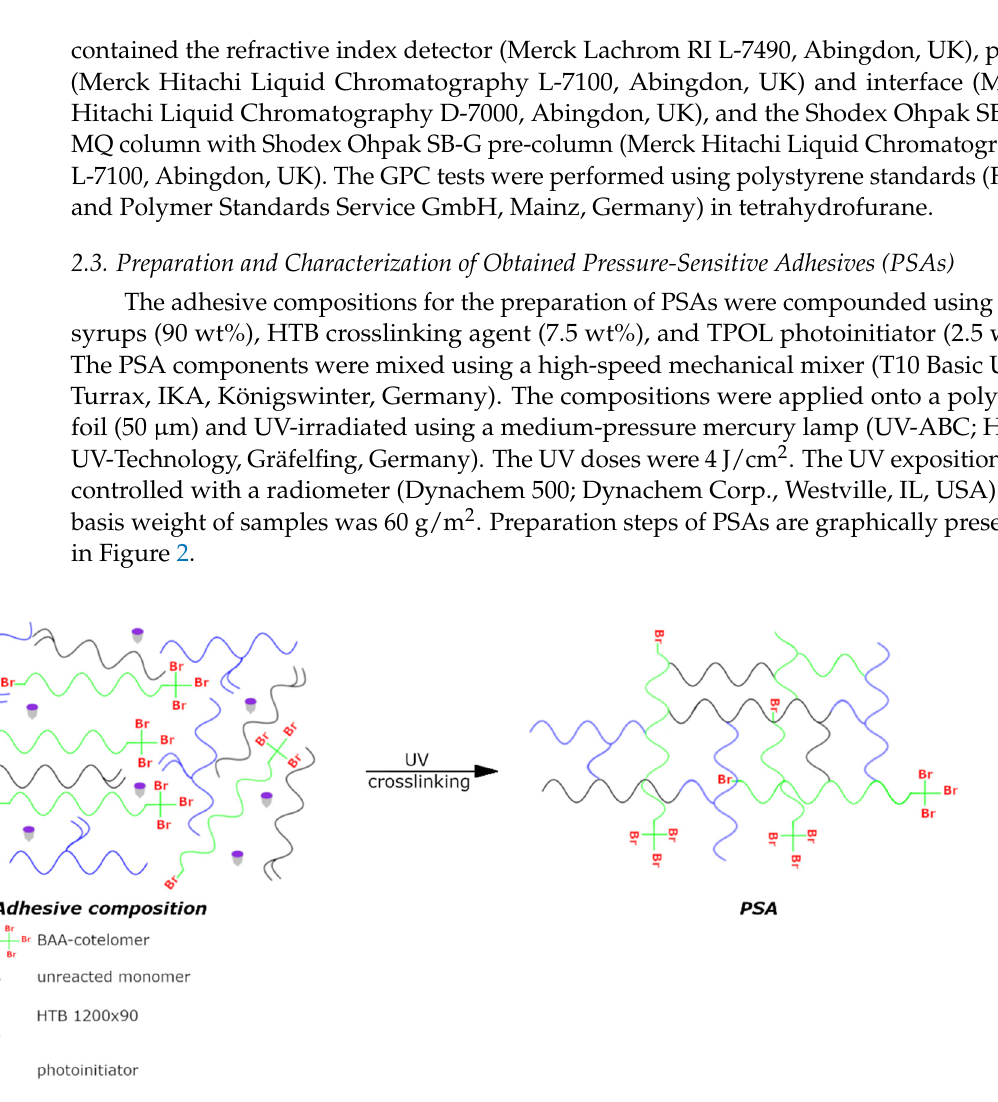
Figure 2. Preparation steps of the pressure-sensitive adhesives from BAA cotelomers. Self-adhesive tests (adhesion to a steel, tack, and cohesion at 20 °C and 70 °C) were performed at 23 ± 2 °C and 50 ± 5% relative humidity. Adhesion is defined as the force value required to remove pressure-sensitive material from a stainless-steel plate; the removal proceeded at an angle of 180° with a speed of 300 mm/min. Adhesion to a steel substrate was tested according to AFERA standards (Association des Fabricants Europe’ens de Rubans Auto-Adhe’sifs), i.e., AFERA 5001. Tack is characterized by a force value required to separate the stainless-steel plate and adhesive tape applied under low pressure for 0.5 s. The tack measurements were performed according to AFERA 5015. The mentioned tests were carried out with the strength machine Zwick Rolell Z010 (Zwick/Roell, Ulm, Germany). Cohesion (i.e., static shear adhesion) describes the time needed to shear off the adhesive tape sample (under load of 1 kg) from the defined steel surface. The cohesion tests were performed according to FINAT FTM 8. These parameters were evaluated using three samples of each adhesive film. used to determine the glass transition temperature (T g ) values of the UV-crosslinked PSAs. − 80 °C to 250 °C (heating rate of 10 °C/min).